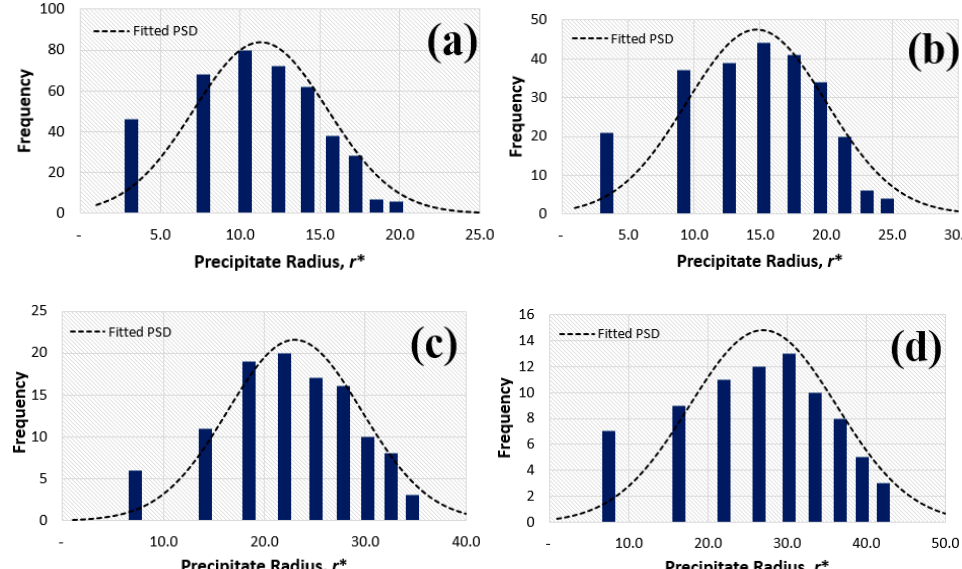
Figure 4. Histograms of the PSD in absence of nanoparticles at different times t * of: ( a ) 1000, ( b ) 2500, ( c ) 10,000, and ( d ) 20,000.